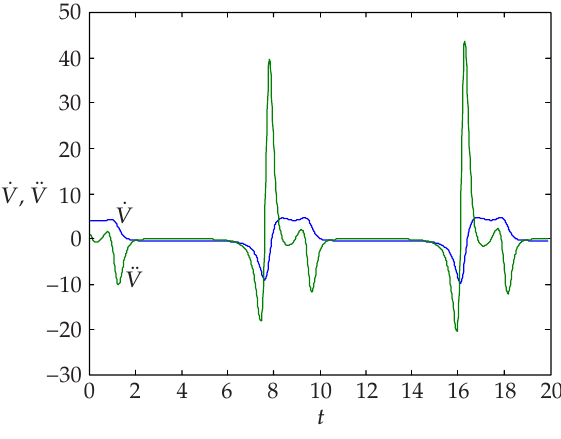
Figure 2.4 . First ˙ V and second ¨ V derivatives of the action